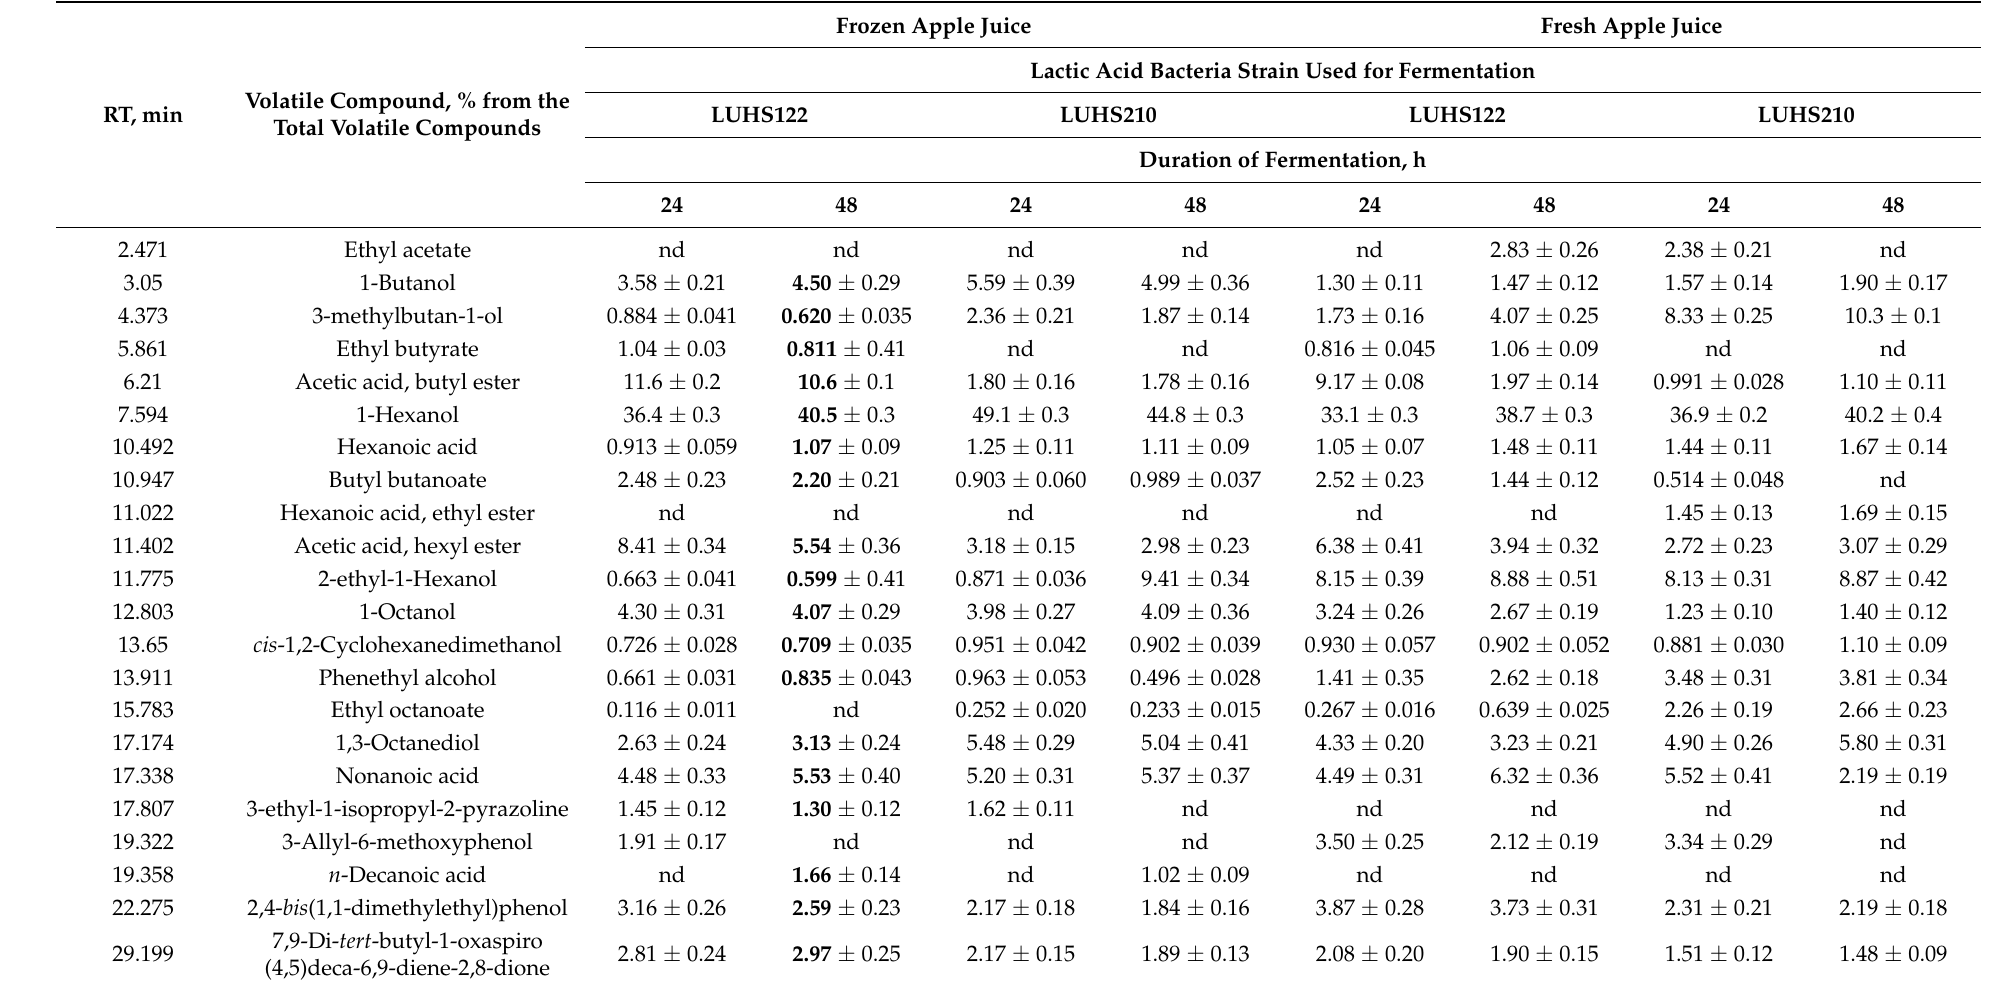
Table 13. Volatile compound profile (% from the total volatile compounds) of fermented apple